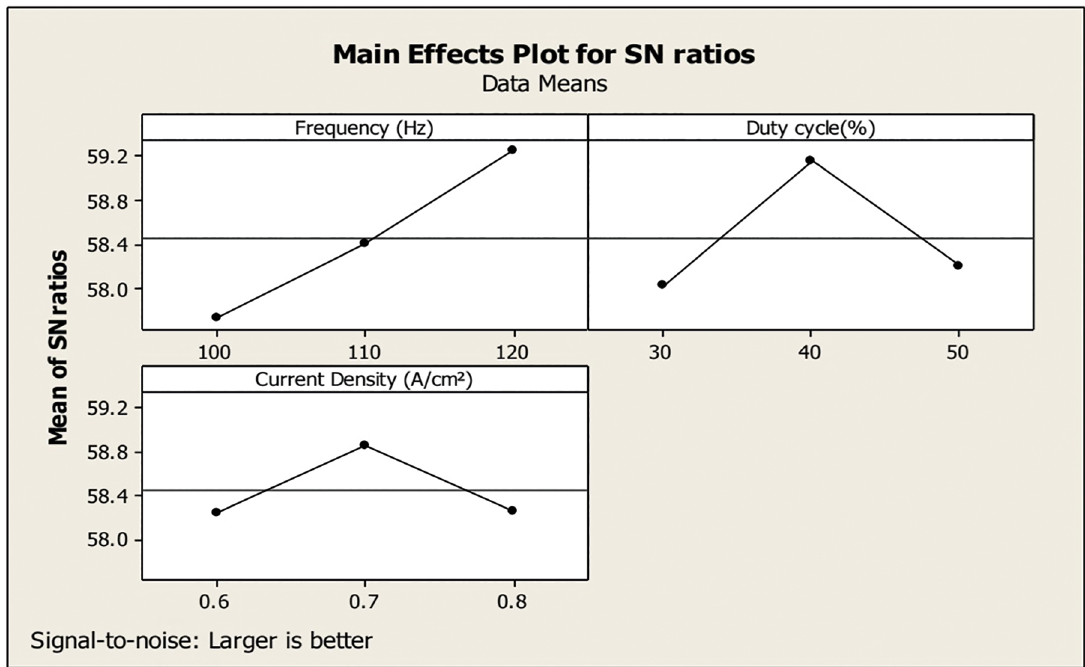
O composite 2 3